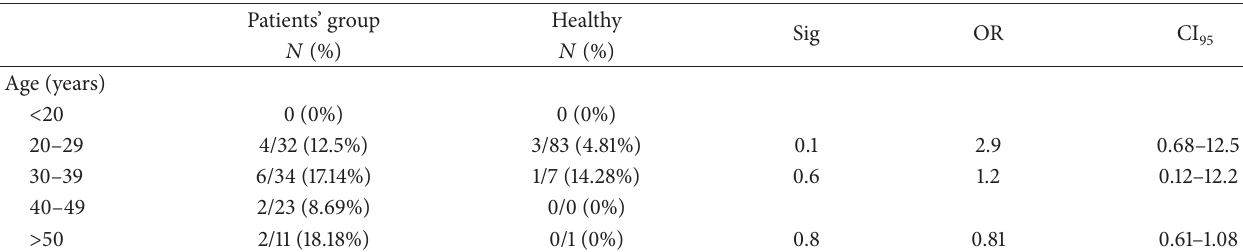
Table 8: The distribution of toxocariasis according to the age in patients with schizophrenia disorder and healthy controls. Patients’